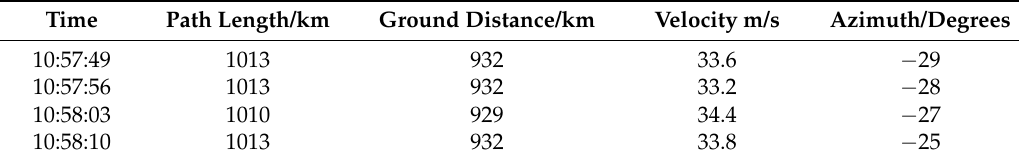
Table 2. Tracking parameters of Track B.